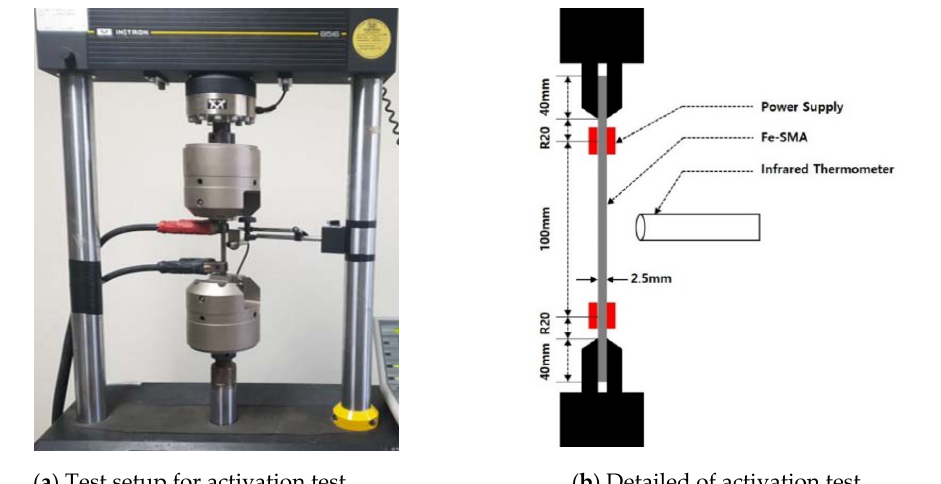
Figure 2. Test setup for activation test.